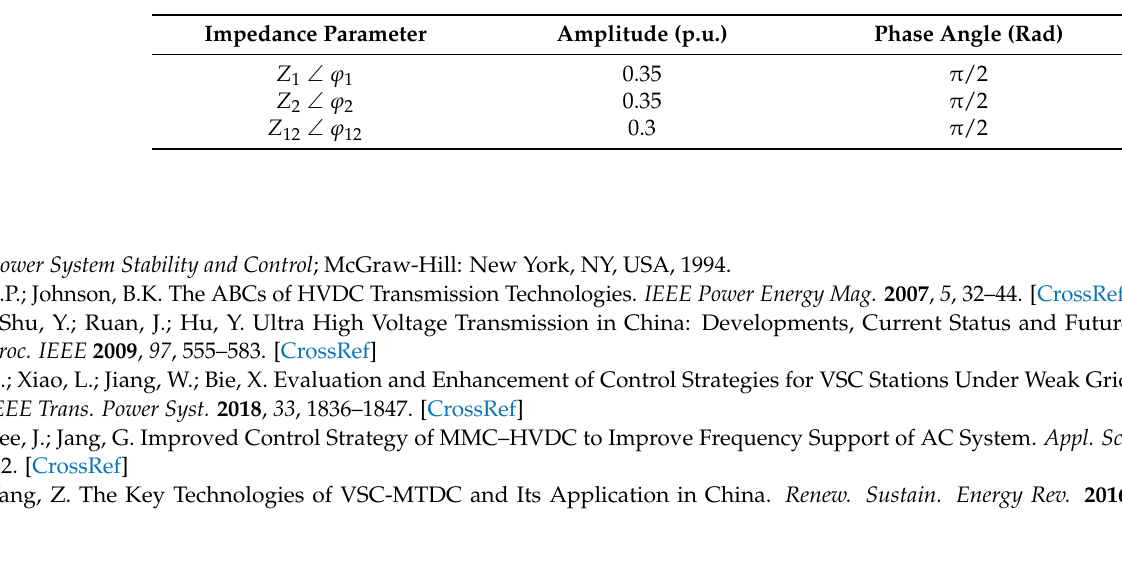
Table A2. Parameters of the receiving-end power